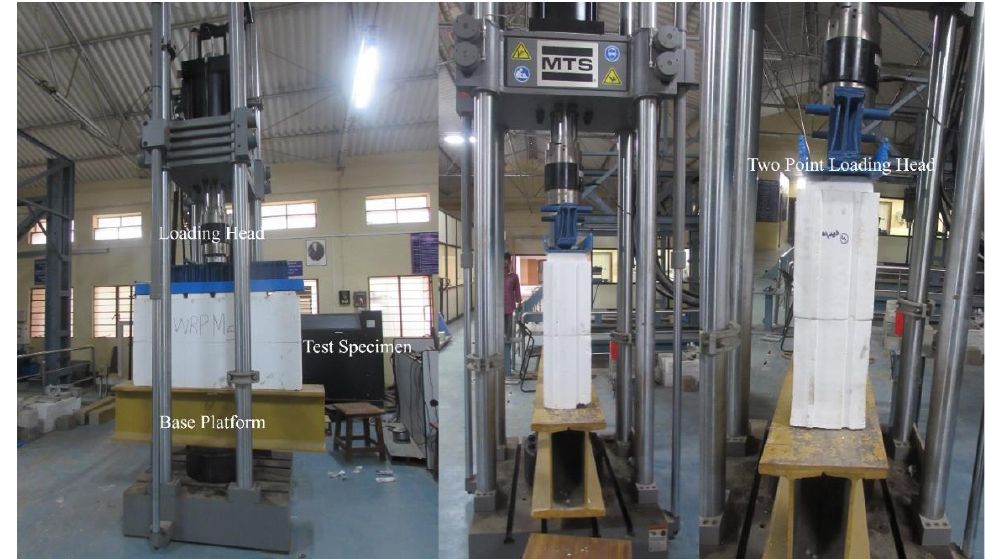
Figure 6. Load testing setup of ICF in MTS (axial compression tests).